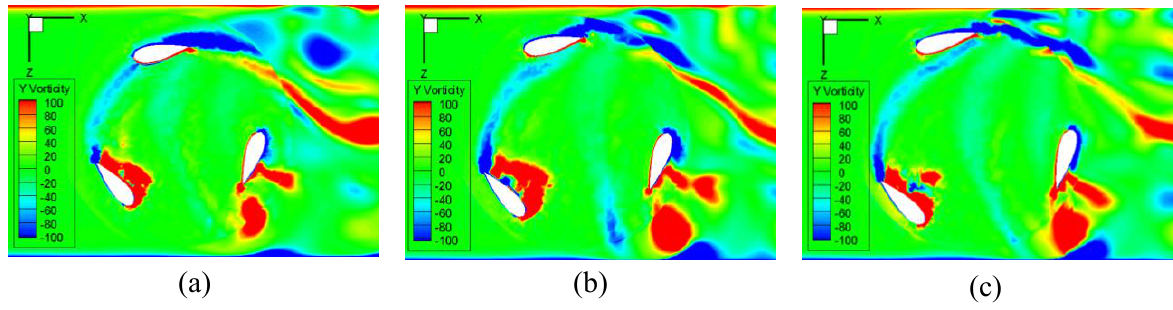
Figure 17. Y-vorticity contours on y = 0.1D_turbine at TSR = 2.4 with a tip clearance of ( a ) 19.3%, ( b ) 15.0% and ( c ) 12.0%.